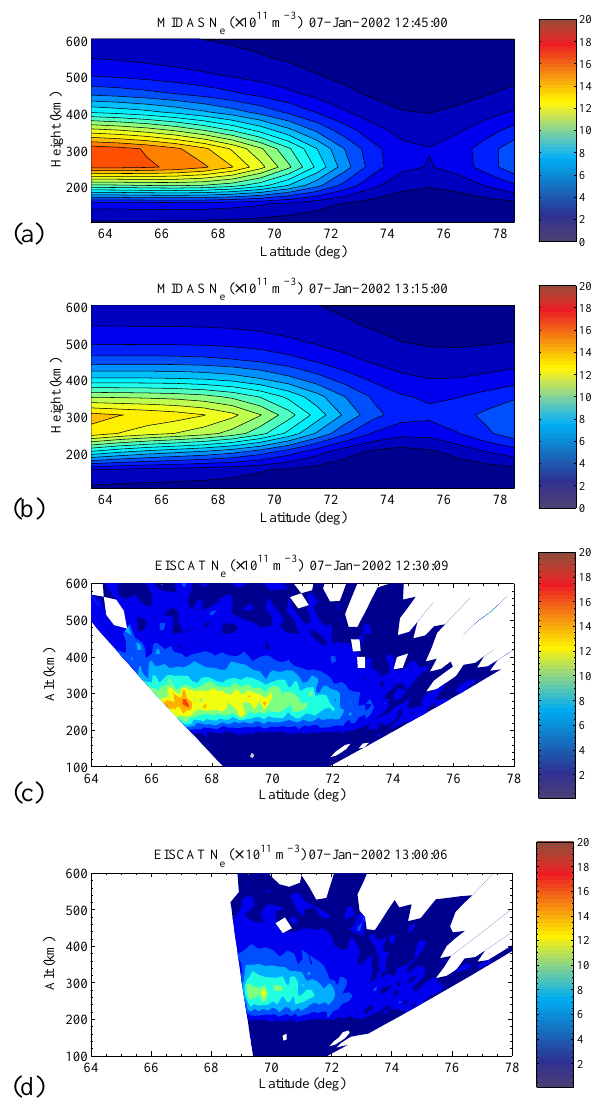
Fig. 2. Electron concentration at the longitude of the EISCAT radar between 12:30 and 13:30 UT: ( a ) and ( b ) plotted from GPS data using MIDAS; ( c ) and ( d ) plotted from EISCAT data.